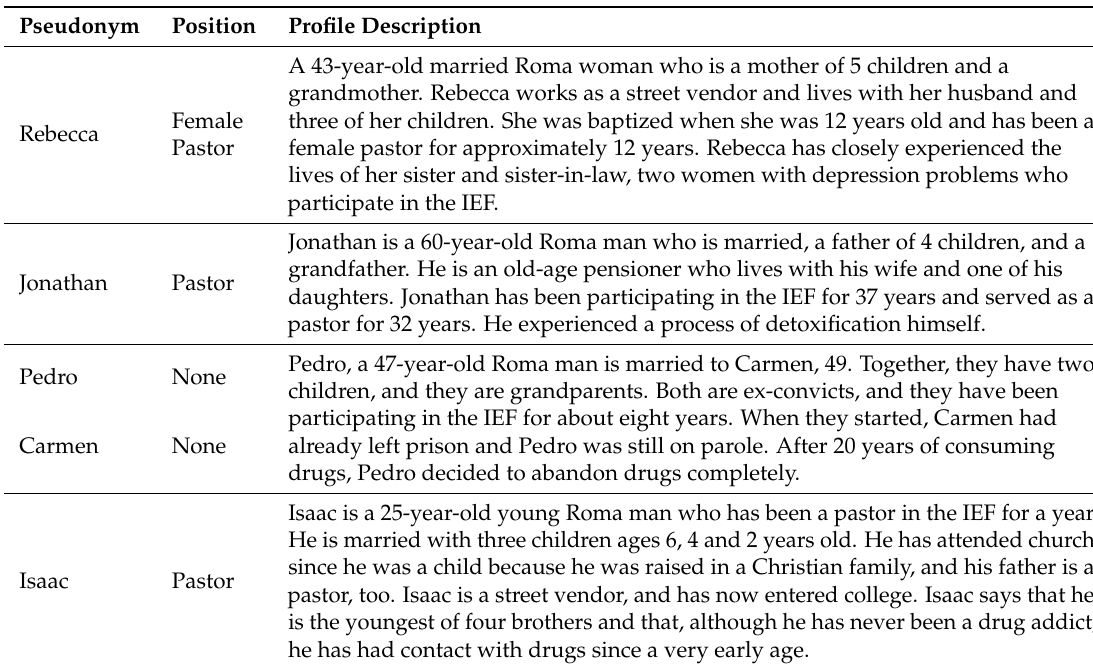
Table 1. Study participants’